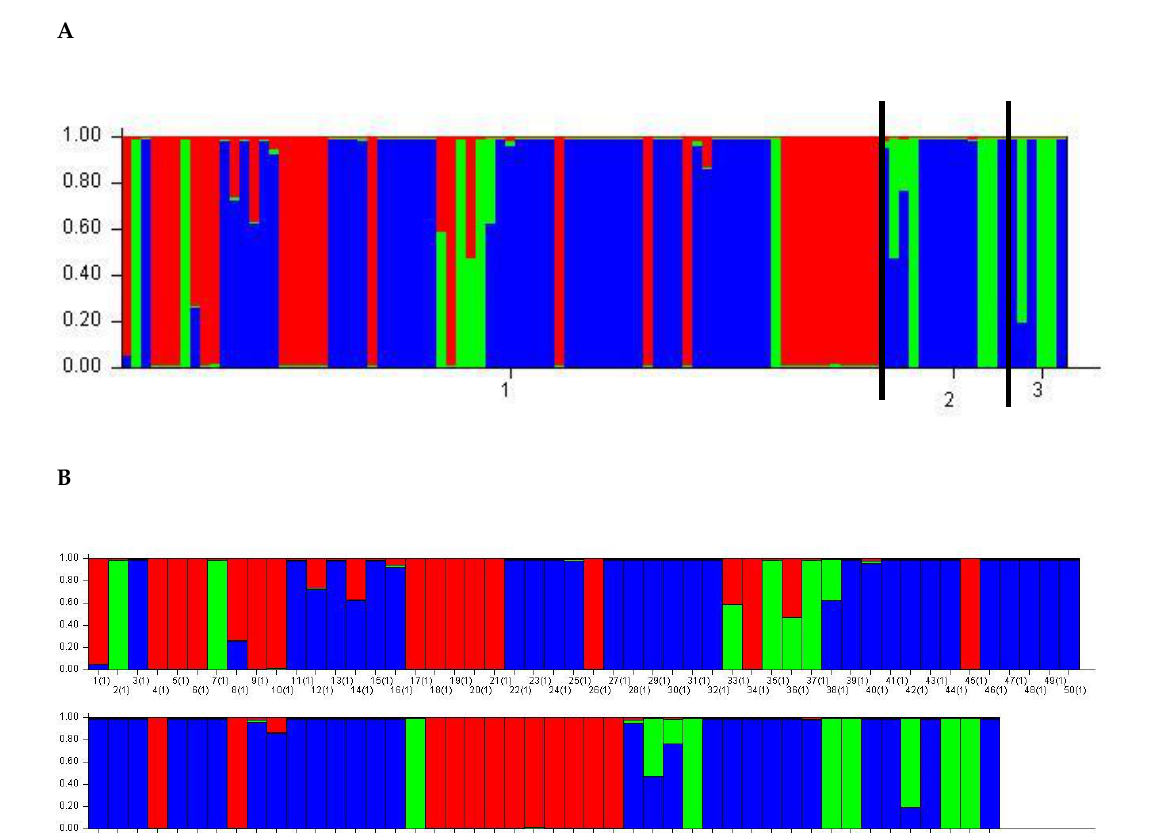
Figure 5. ( A ) Bayesian model-based estimation of population structure ( K = 2) for 96 D. rabiei isolates into three groups (blue, red, and green), and each vertical line represents one individual, and each population is divided by a black line (numbered as 1,2,3). Each color shows the genetic composition that is assigned to a different genetic cluster ( B ) Population structure analysis (blue, Pop-A; red, Pop-B; green, Pop-C; (the isolates that did not share more than 70% of ancestry were considered admixtures). The lengths of the colored segments on the Y -axis show the estimated membership proportions of each isolate in the group (coefficient of membership), and the numbers on the X -axis refer to the isolate numbers.